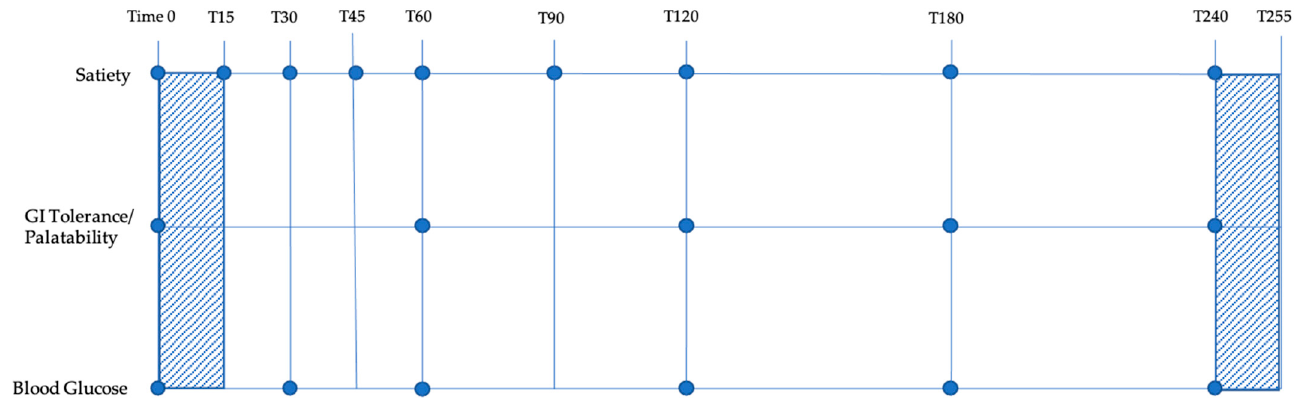
Figure 1. Data collection timeline on day of AG supplementation.